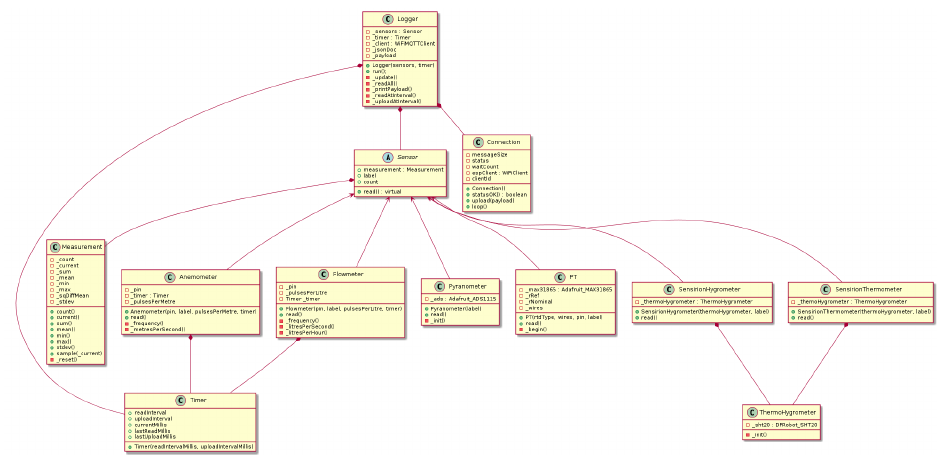
Figure A1. ESP32 software class